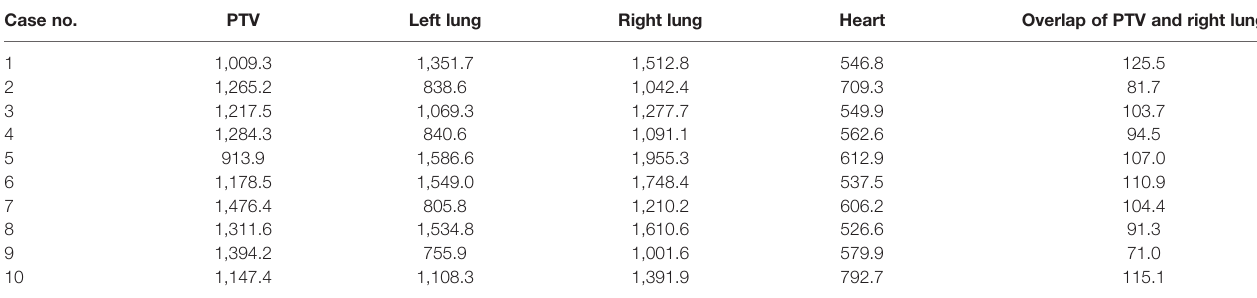
TABLE 2 | Structure volumes of right-sided PMRT cases. Case no. PTV Left lung Right lung Heart Overlap of PTV and right